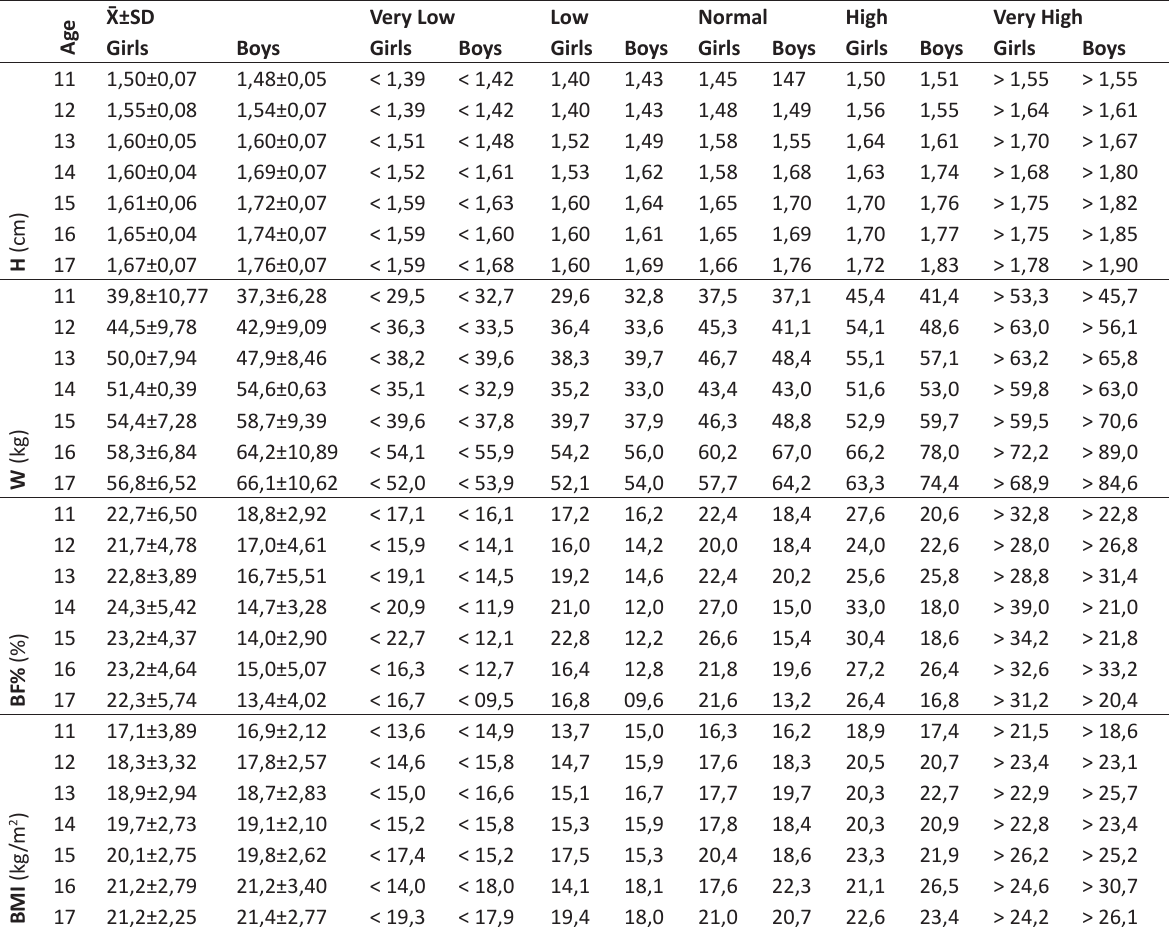
Table 1. Heigh, Body Weight, Body Fat Percentage, Body Mass Index Normative